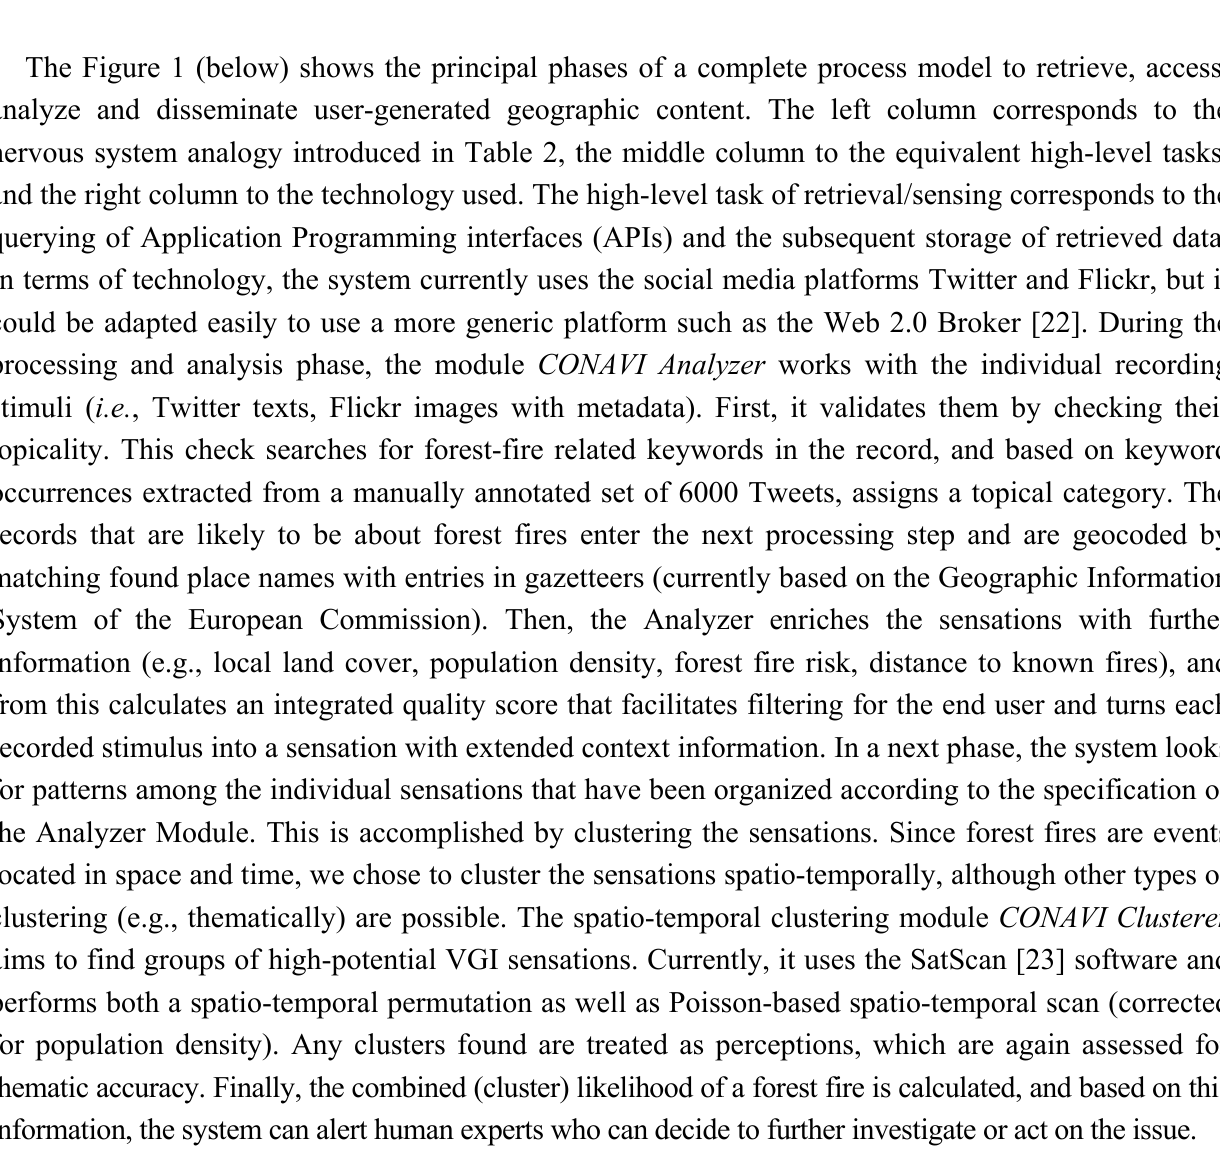
Figure 1. Overview of approach for sensing and